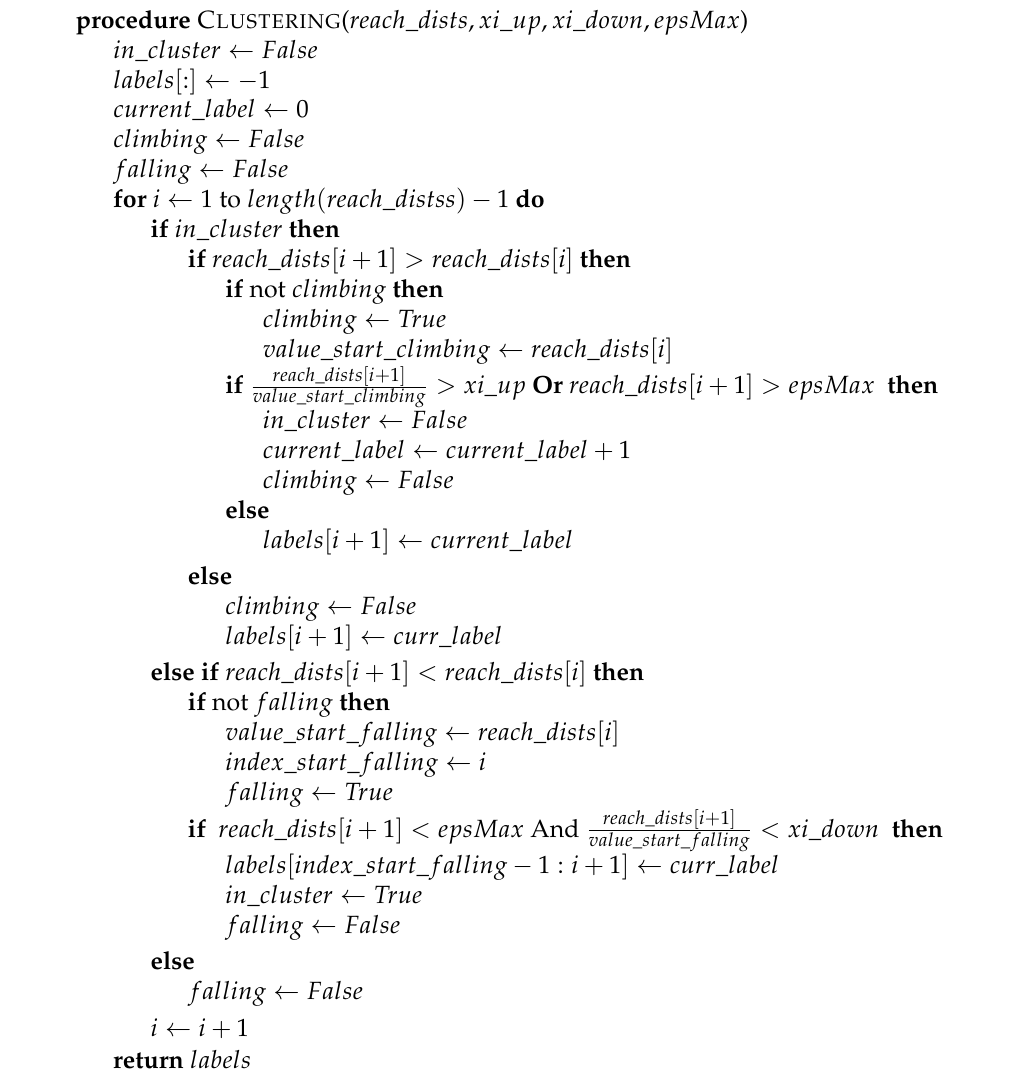
Algorithm A2 Reachability distance-based